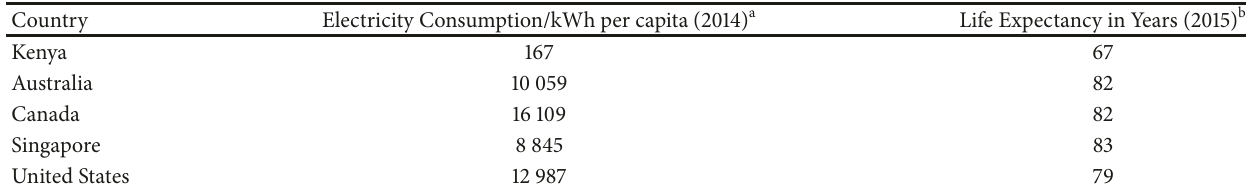
Table 4: Electricity consumption and life expectancy for selected